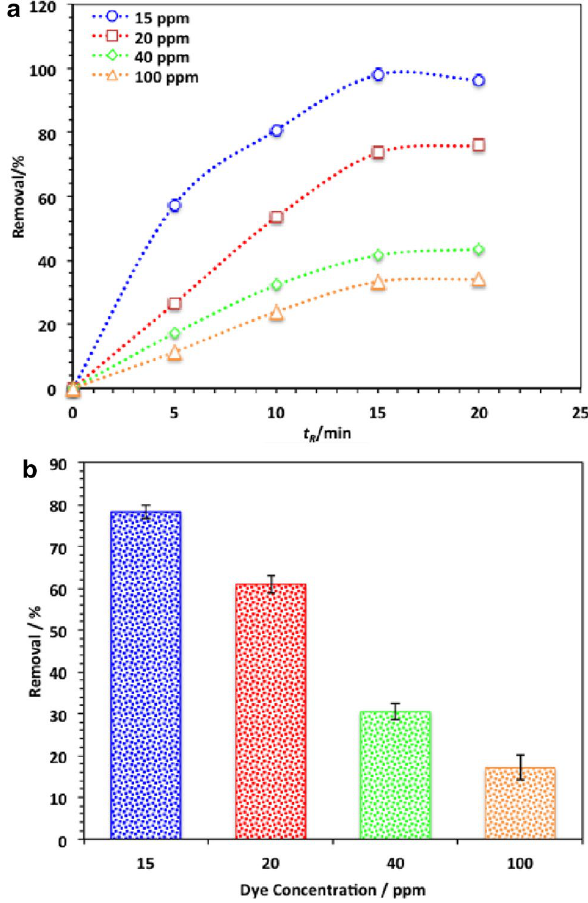
Fig. 5 The effect of Synozol Blue load on the Mn